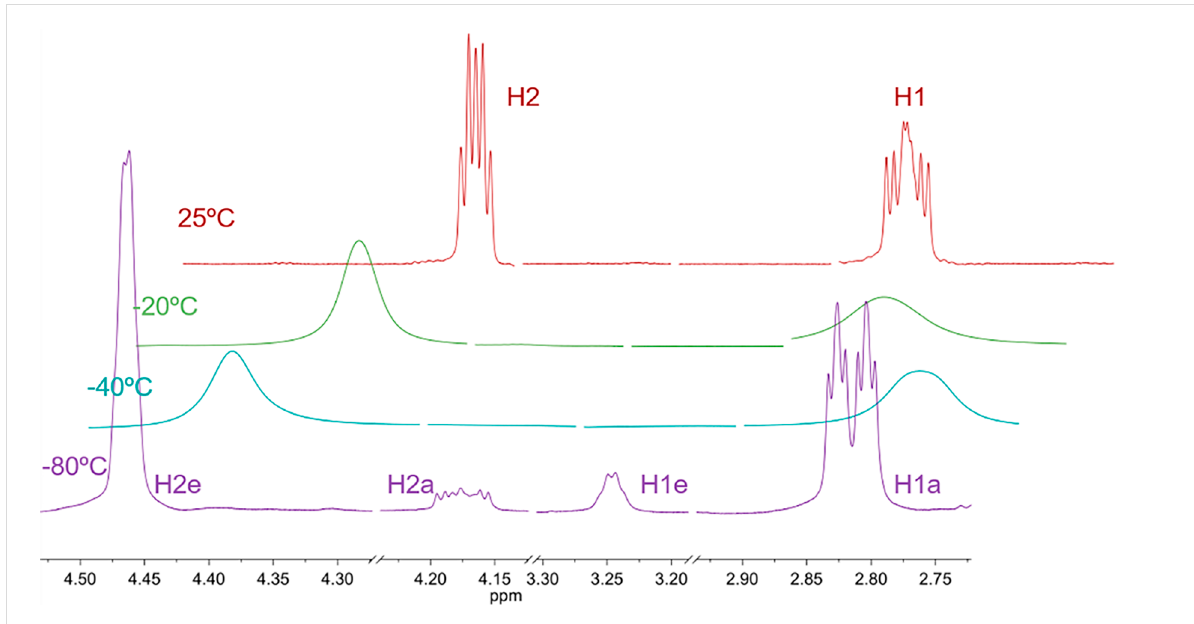
Figure 2: Variable-temperature 1 H NMR spectra (500.13 MHz) for cis -2-chlorocyclohexylamine in dichloromethane- d 2 .